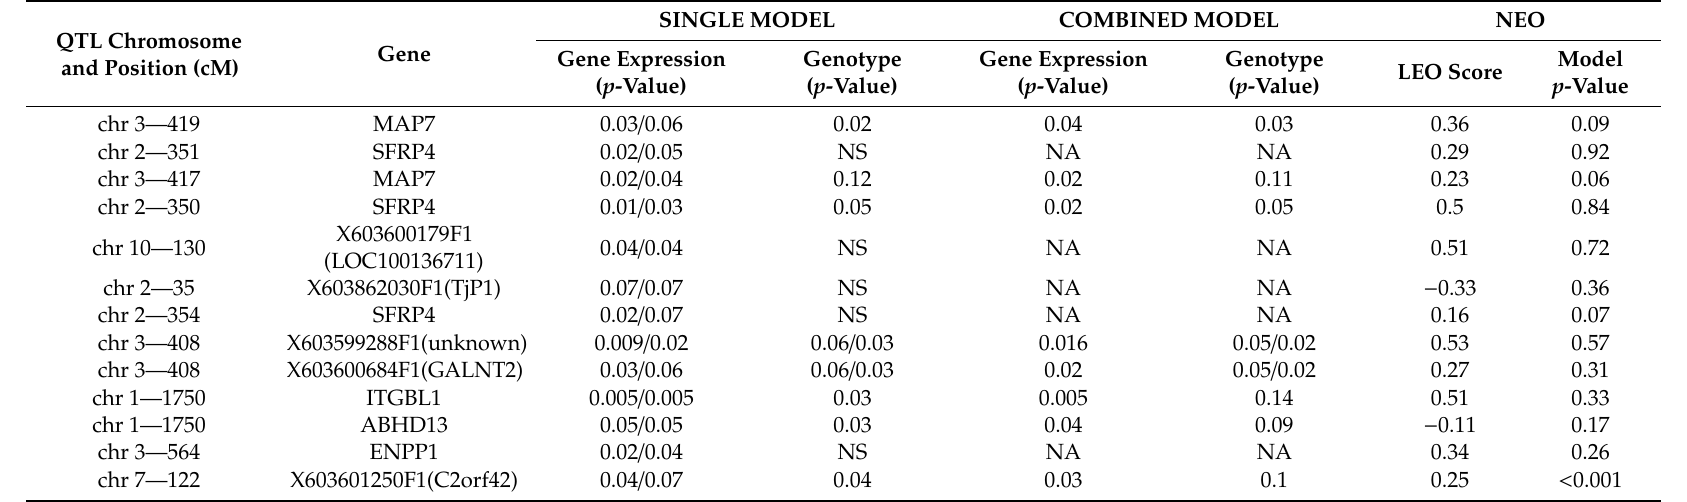
Table 3. Candidate genes and causality